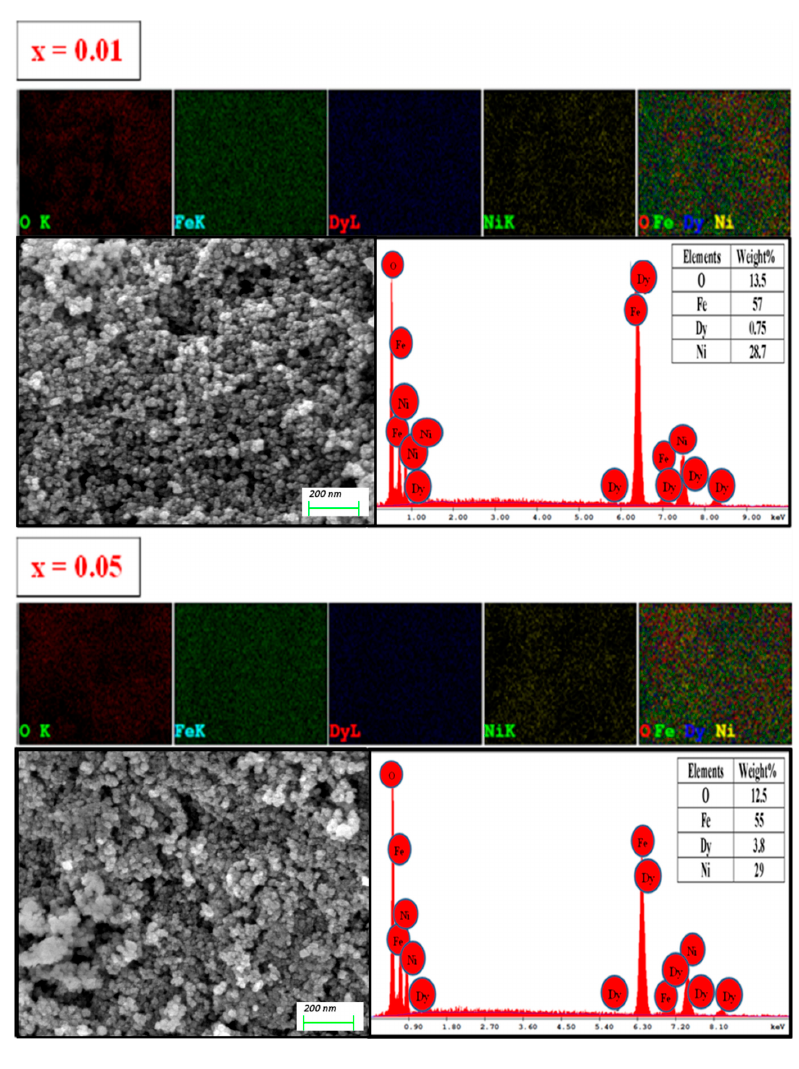
Figure 2. Elemental mapping, Scanning electron microscope (SEM) images and dispersive X-ray spectroscopy (EDX) of two selected x = 0.01 and 0.05 NPs.